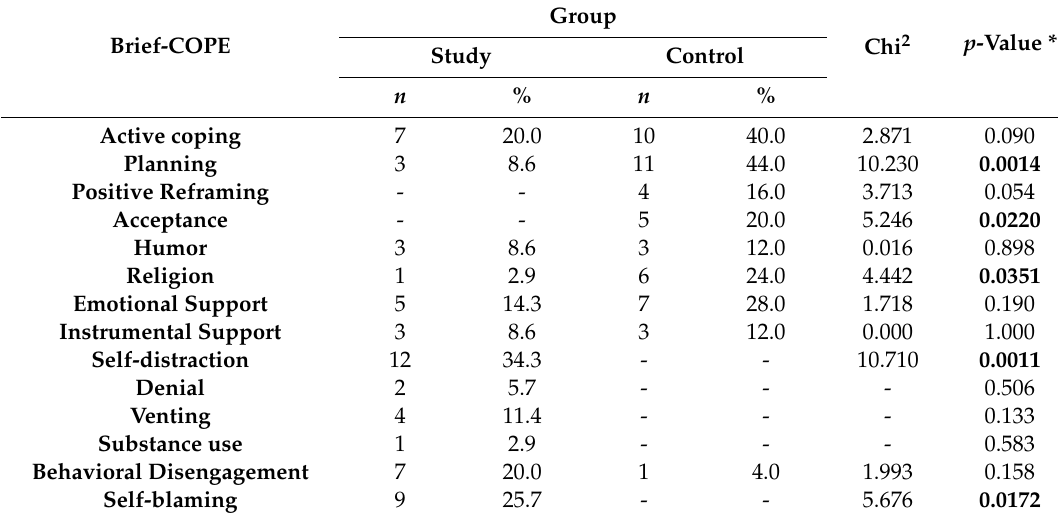
Table 6. Comparison of the frequency of selected methods of coping with stress by persons from the study and control